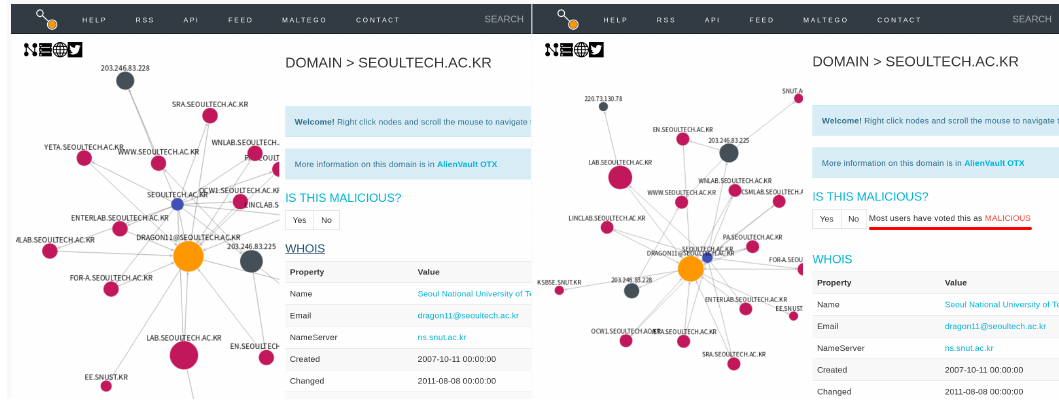
Figure 2. Change in a reputation of the ’seoultech.ac.kr’ domain before (left) and after (right) a Sybil attack in the OSINT CTI service ( threatcrowd.org [12]). The right screen shows that an attacker has created a bad reputation (underlined in red) for that domain through a Sybil